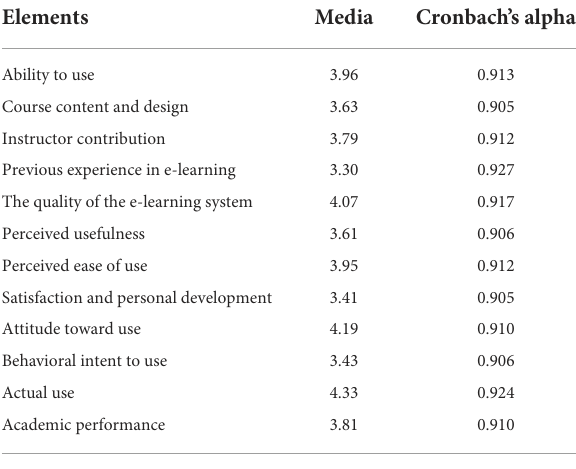
TABLE 7 Reliability of elements based on Cronbach’s alpha.